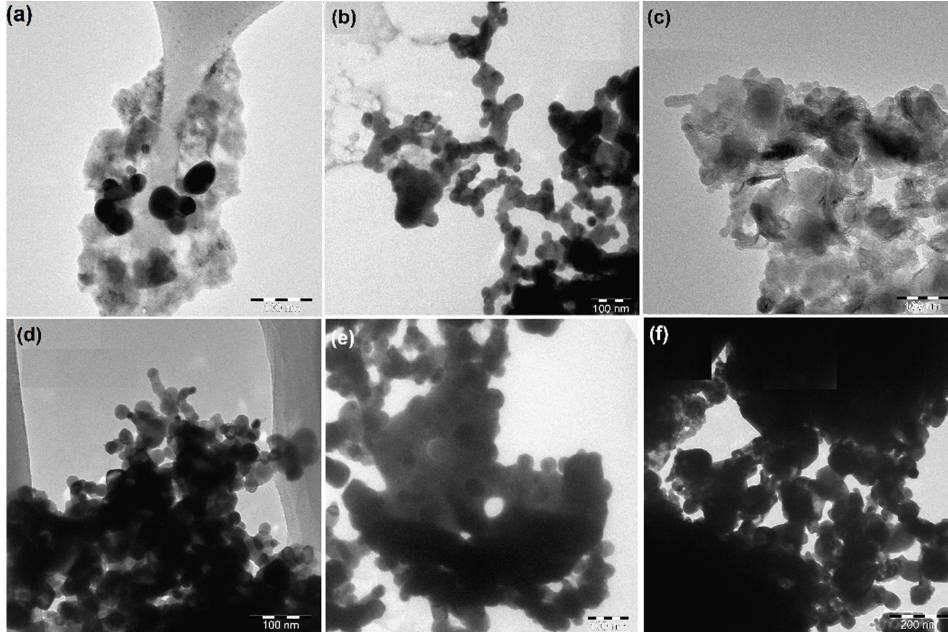
Figure 3. TEM images of ( a ) fresh CeNiO 3 , ( b ) reduced CeNiO 3 , ( c ) used CeNiO 3 , ( d ) fresh SrNiO 3 , ( e ) reduced SrNiO 3 , and ( f ) used SrNiO 3 .